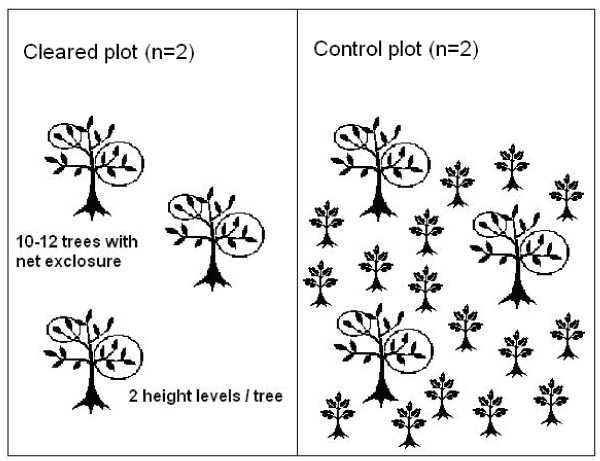
Experimental setup. The experiment was replicated at two sites. Each site was divided in two plots of equal area which were randomly assigned to either understory clearance or no management (control). Bird exclosures were placed in 10-12 trees in each plot, at two height levels in each tree.